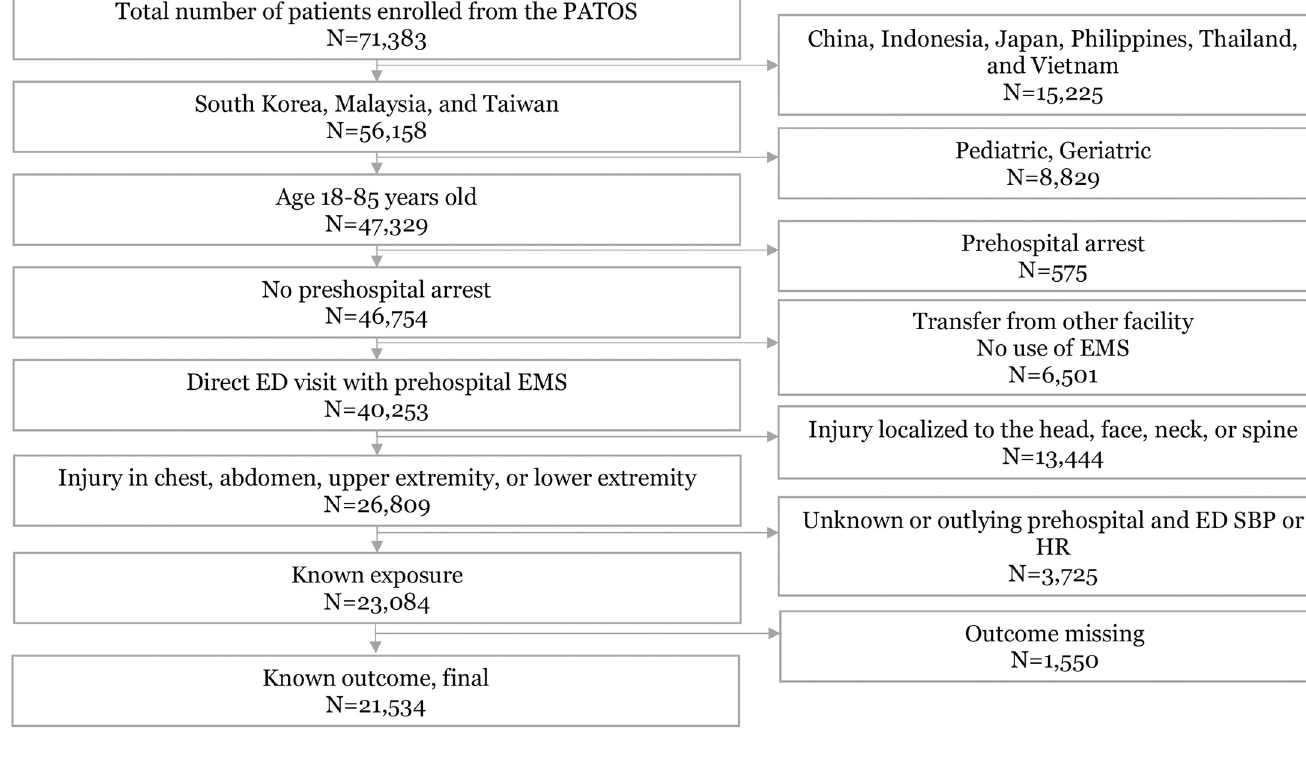
PLOS ONE | https://doi.org/10.1371/journal.pone.0258811 October 25,